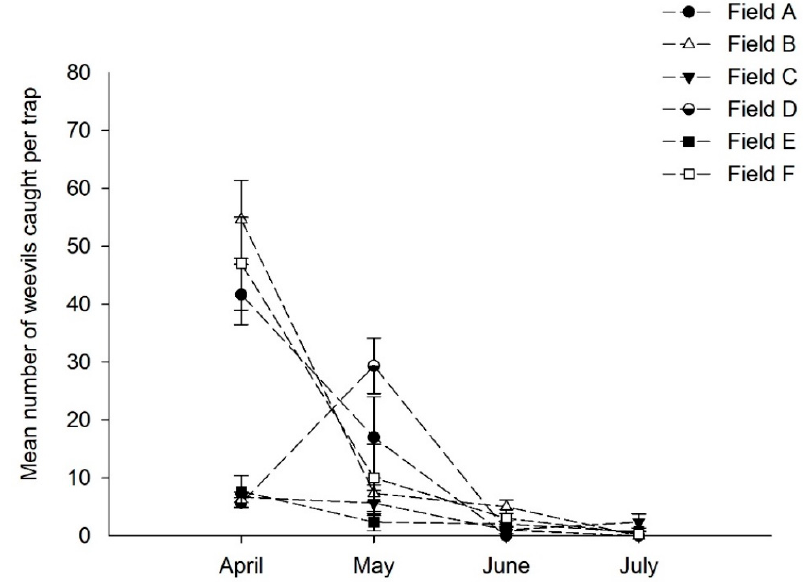
Figure 3. Sitona lineatus adults captured by pitfall traps baited with pheromone at six experimental sites in the Golden Triangle, Montana.